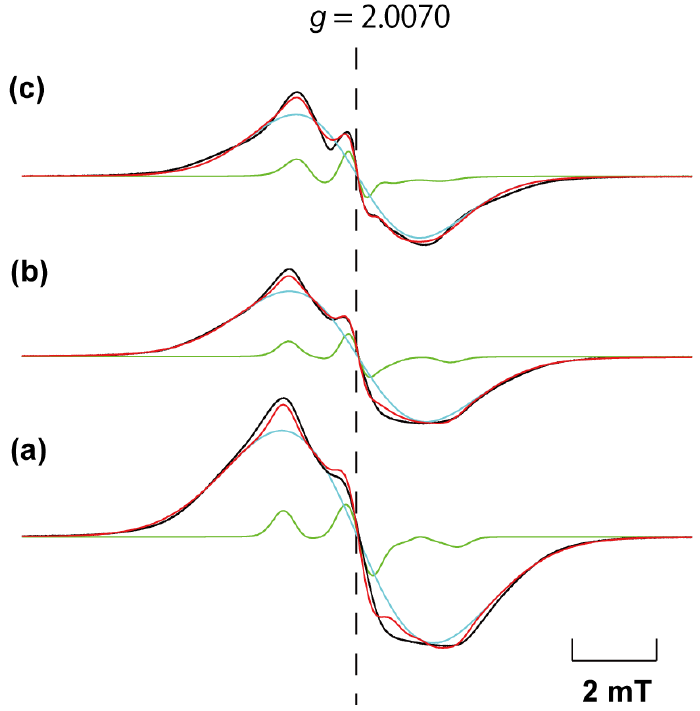
Figure 6. Powder ESR spectra of compound 2 at 143 K (a) , 223 K (b) , and 283 K (c) . All spectra (black line) were reproduced by a superposition (red line) of two temperature- dependent components: an isotropic broad signal (cyan) and an anisotropic slow averaging one (green), as observed in the TPP/TEMPO IC or the IC using TEMPOL and TPP prepared by the adsorption method